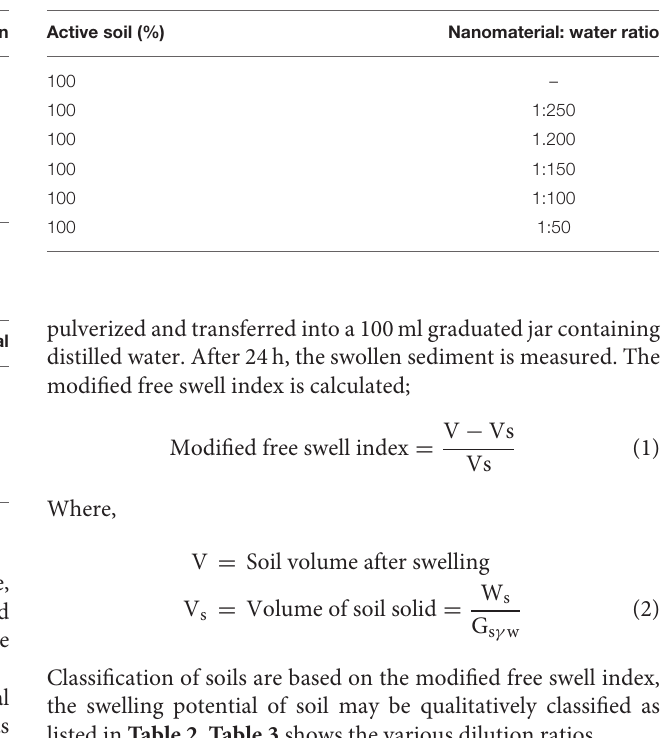
TABLE 3 | Physical properties of studied active